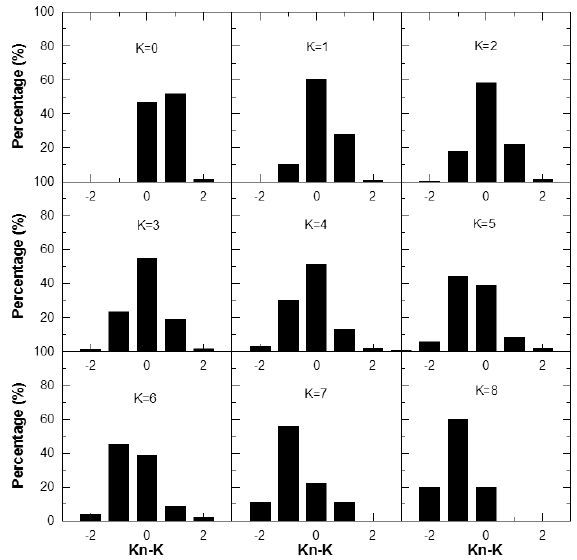
Figure 4. Histograms with the percentage of differences between Kn and K for each class of